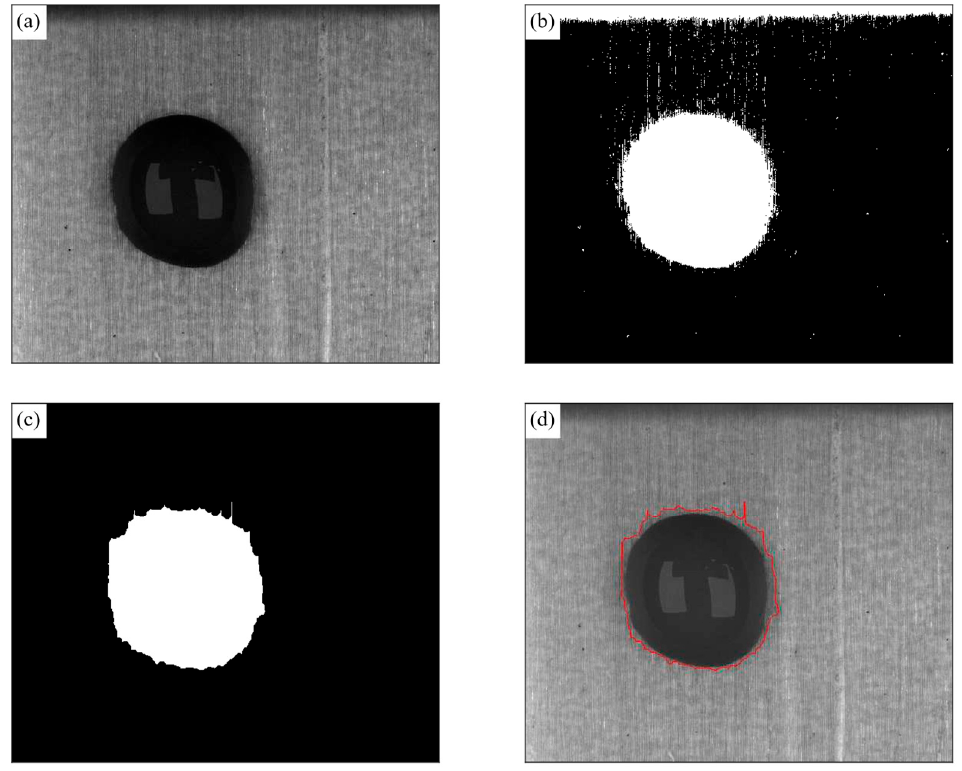
Figure 7. Droplet image processing using the thresholding method at various steps: ( a ) grayscale, ( b ) Otsu threshold, ( c ) filtered, and ( d ) boundary traced.